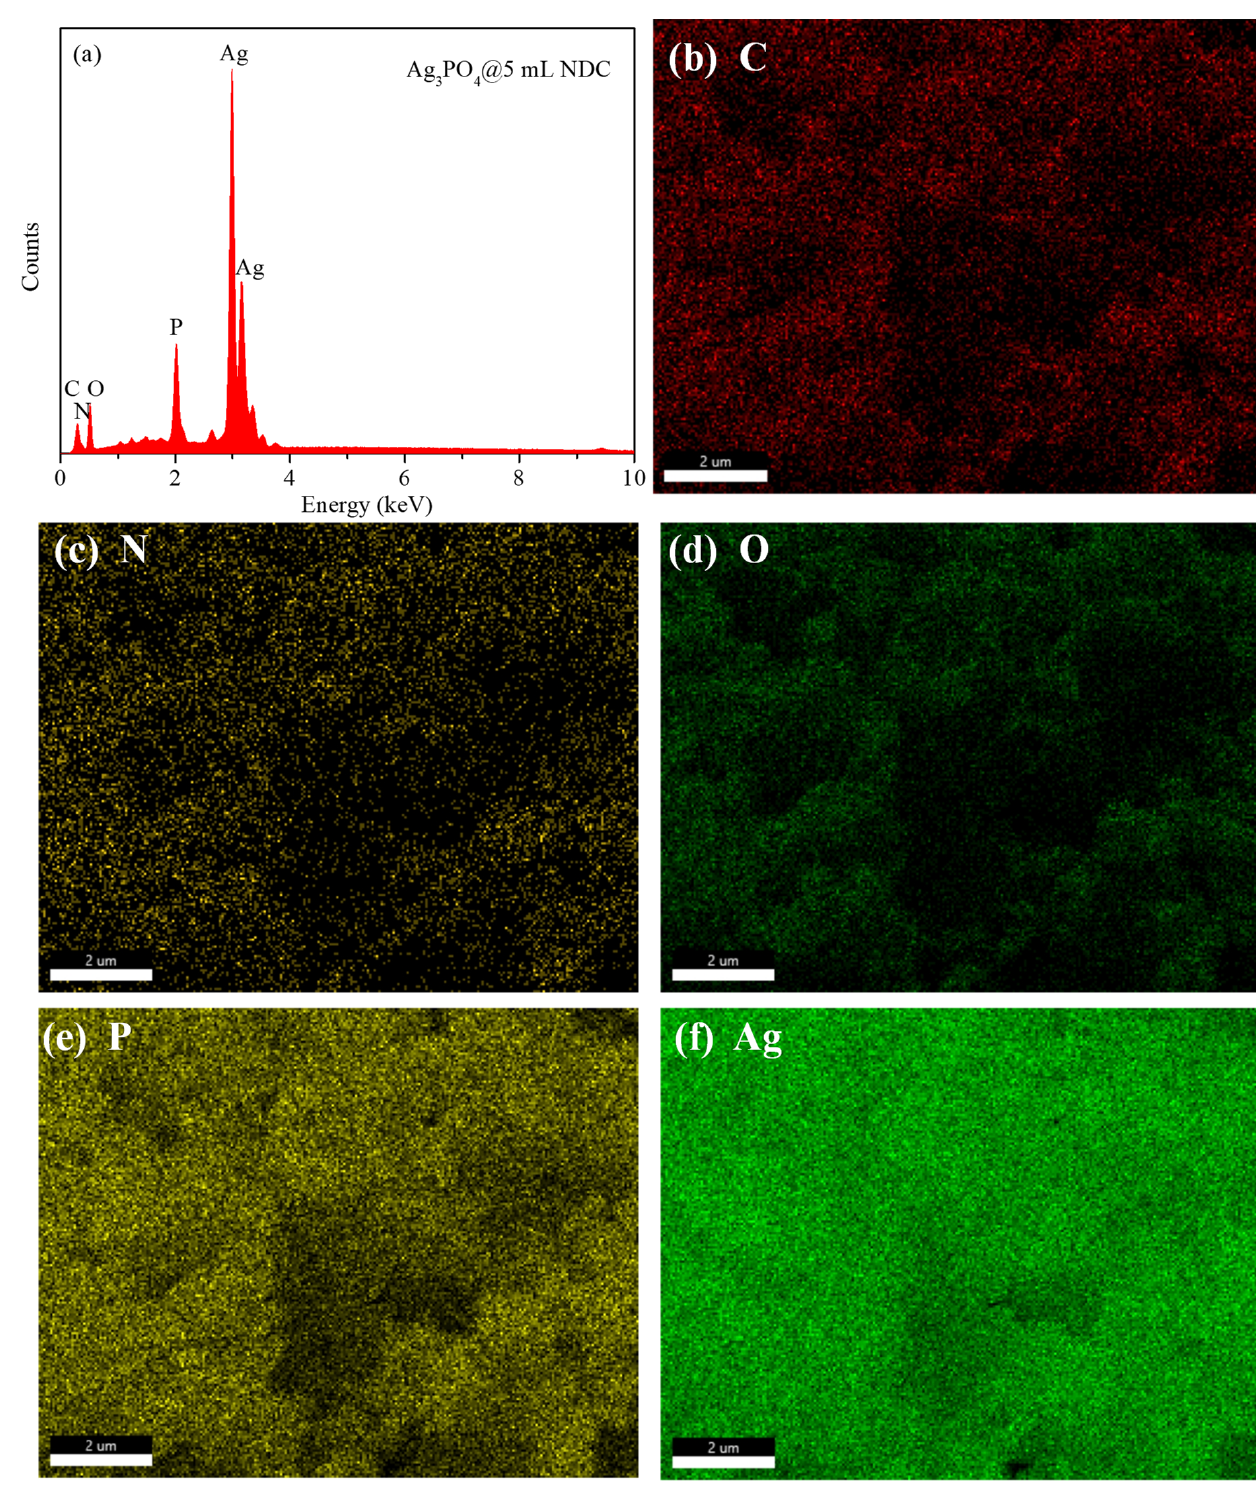
Figure 3. SEM-EDS elemental mapping images of Ag 3 PO 4 @NDC composite: ( a ) EDS spectrum and distribution of ( b ) C, ( c ) N, ( d ) O, ( e ) P and ( f ) Ag.